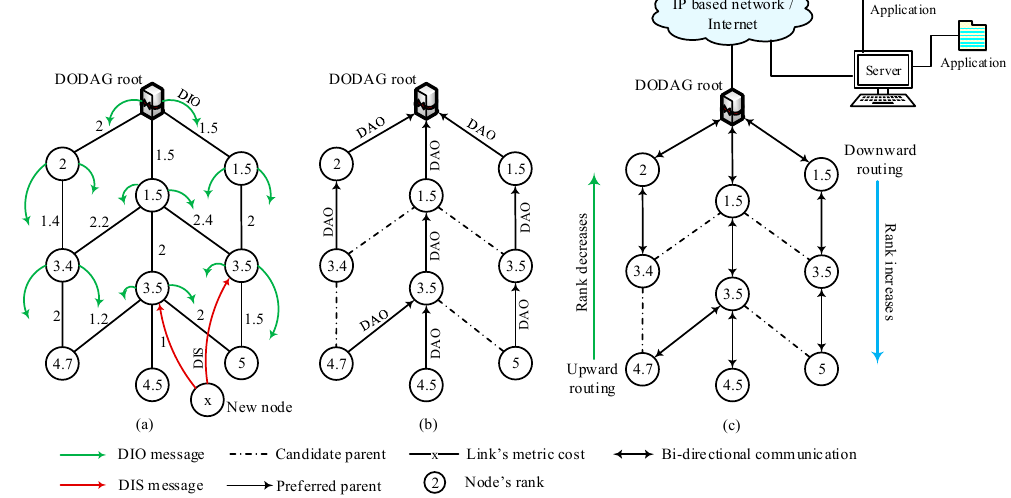
Figure 2. Route building operation; ( a ) DIOs multicast initiated by destination oriented directed acyclic graph (DODAG) root (LBR) and rank calculation. New node intend to join the network; ( b ) propagation of DAOs to build the downward routes; ( c ) complete DODAG with both upward and downward